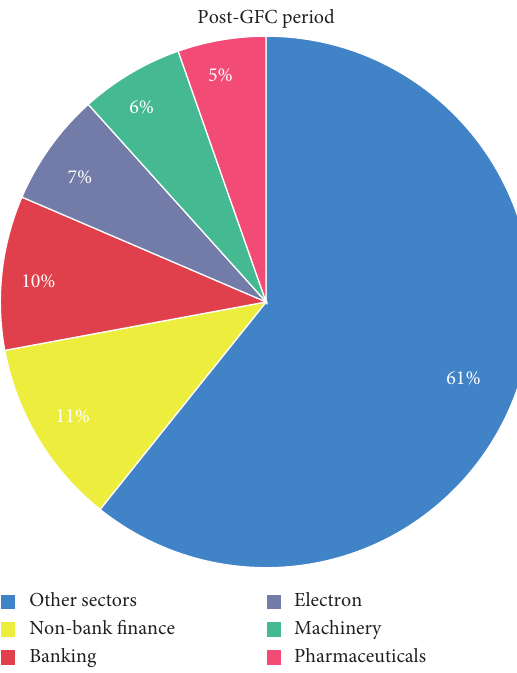
Figure 6: CES in the post-GFC period (%).